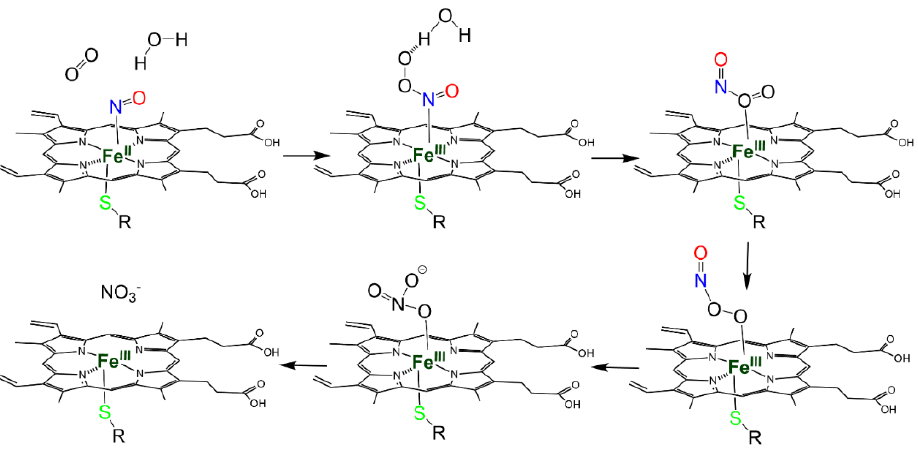
Scheme 6. Proposed k ox reaction of NOS. Simplified from [78]